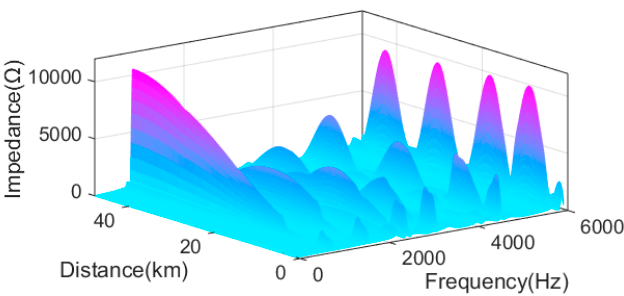
Figure 5. Impedance analysis of traction power supply system.